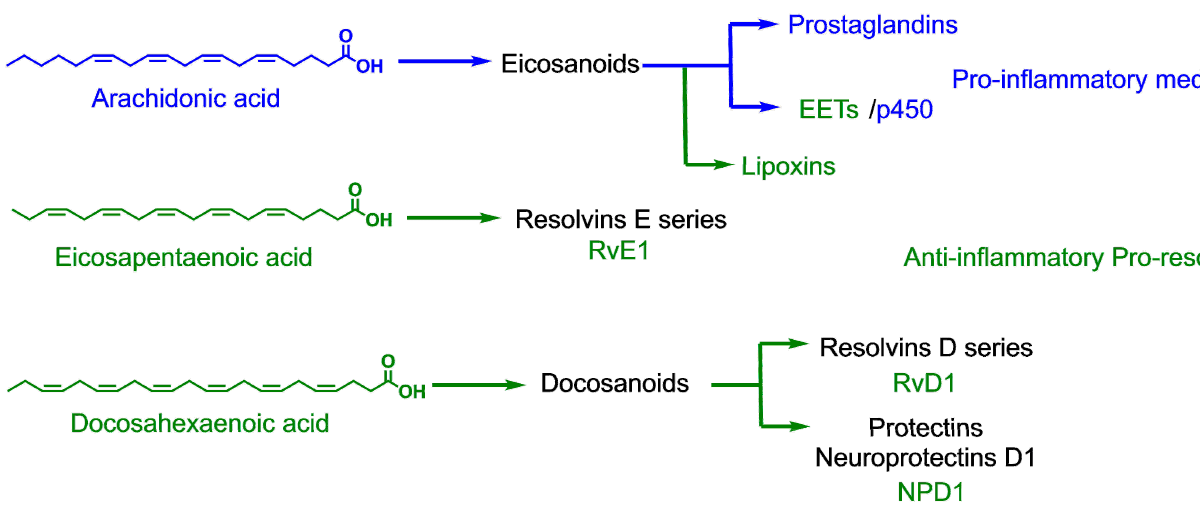
Figure 2. Metabolic pathways of polyunsaturated fatty acid (PUFA) that lead to pro-inflammatory and anti-inflammatory mediators. EET: Epoxyeicosatrienoic acids.